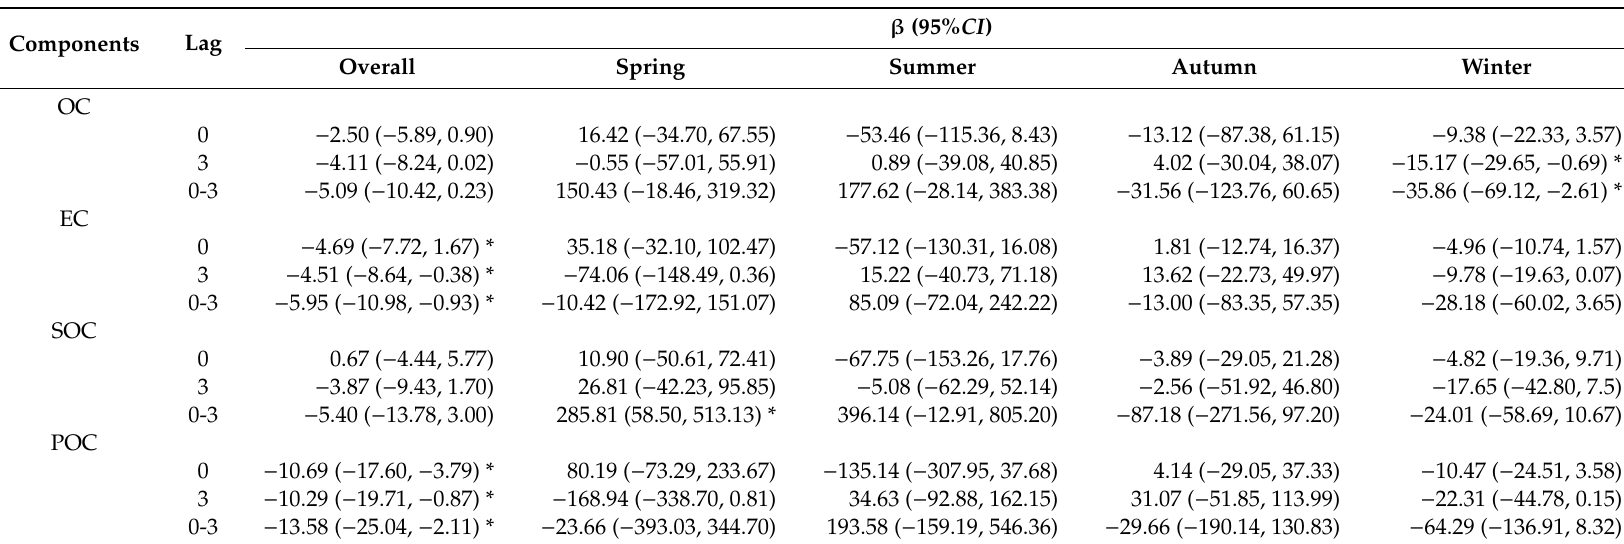
Table 4. Estimated health e ff ects on evening PEF (L / min) with 10 µ g / m 3 increase of outdoor pollution in constituent-PM 2.5 model in di ff erent periods.